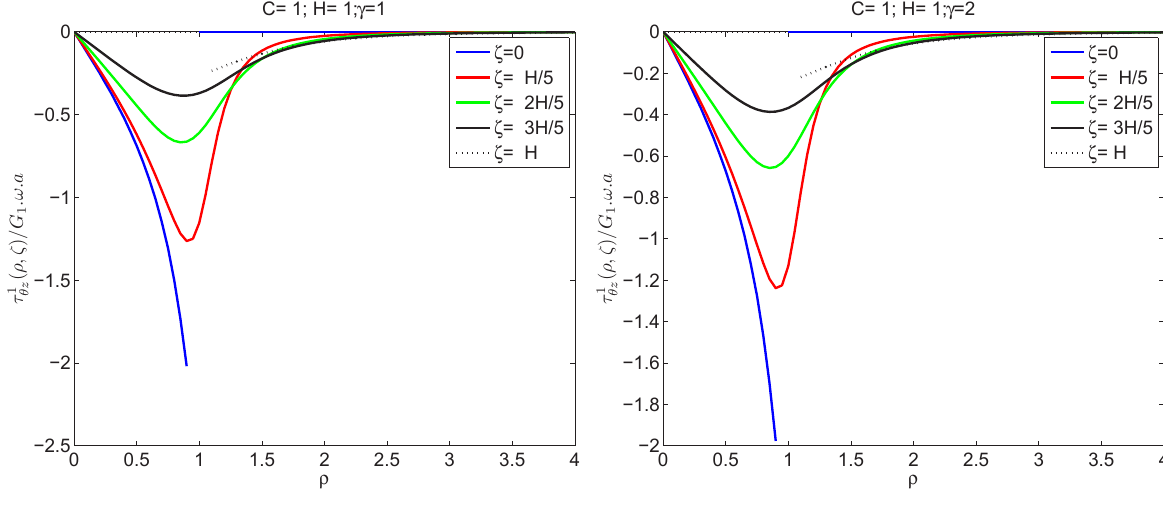
Figure 7: Shear stress τ θz1 versus ρ for various ξ,